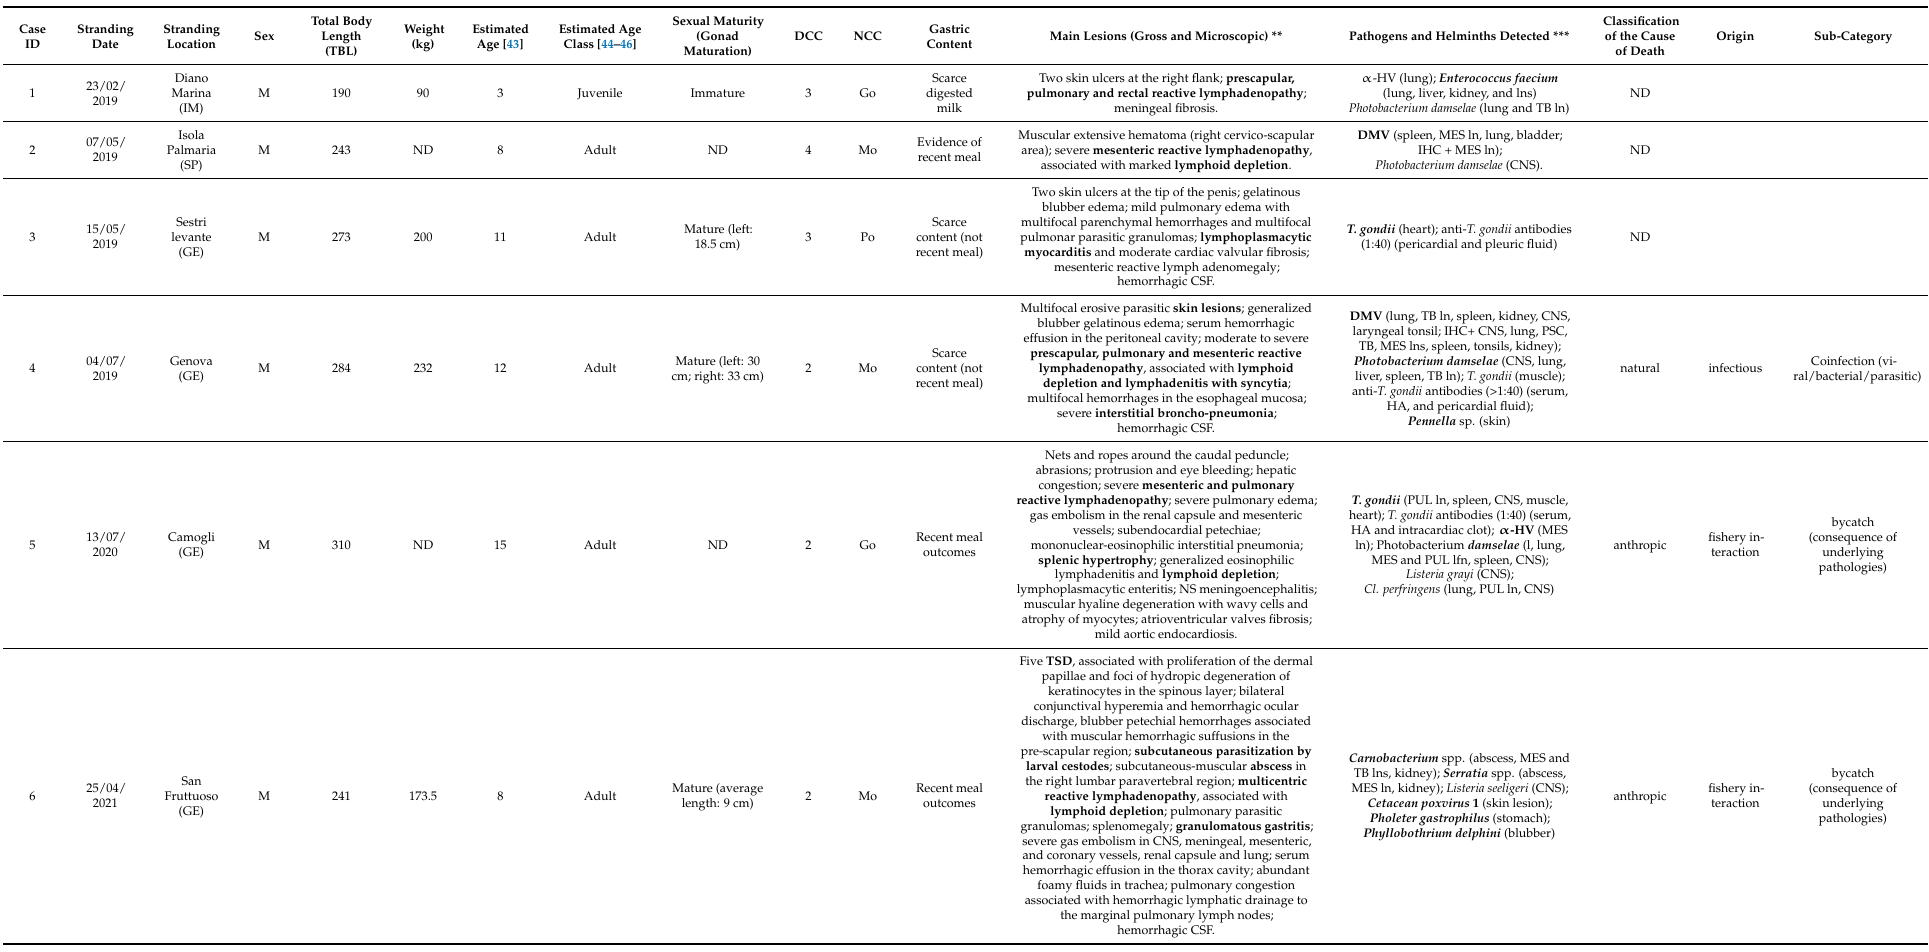
Table 3. T. truncatus stranded dead along the Ligurian coastline between 2019 and 2021 under investigation, arranged in chronological order. For each individual are detailed pieces of information on date and location of stranding, sex, total body length (TBL) (cm), weight (kg), estimated age (years), estimated age class, sexual maturity, decomposition condition category, nutritional condition category, gastric contents, main gross and microscopic lesions, pathogens and helminths detected, classification of the cause of death, origin, and sub-category.